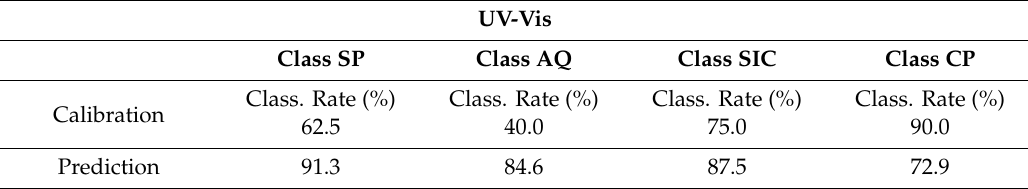
Table A2. PLS-DA analysis: Correct classification rates (%) for calibration (CV) and validation (test